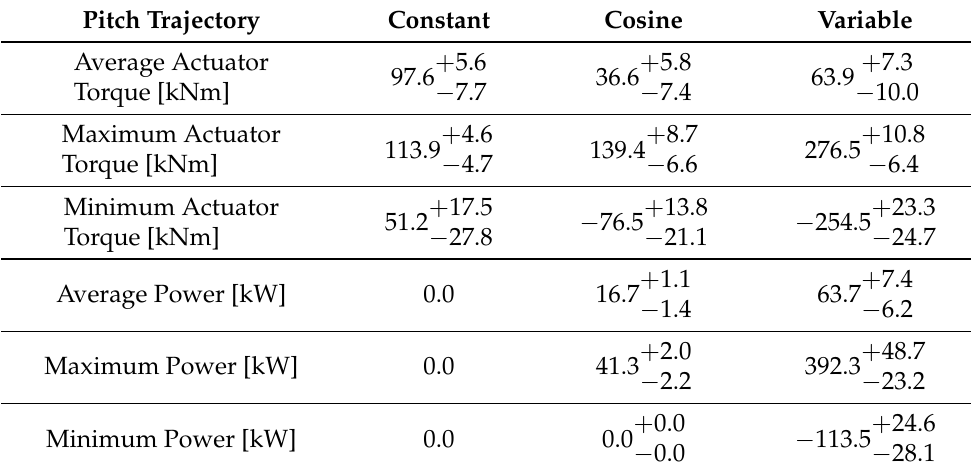
Figure 9. Required actuator torque and power with their uncertainties due to the uncertainty in the hydrodynamic loads for each of the three pitch trajectories. Table 1. Average, maximum and minimum actuator torque and power, along with the uncertainties resulting from the uncertainty in the hydrodynamic loads for each of the pitch